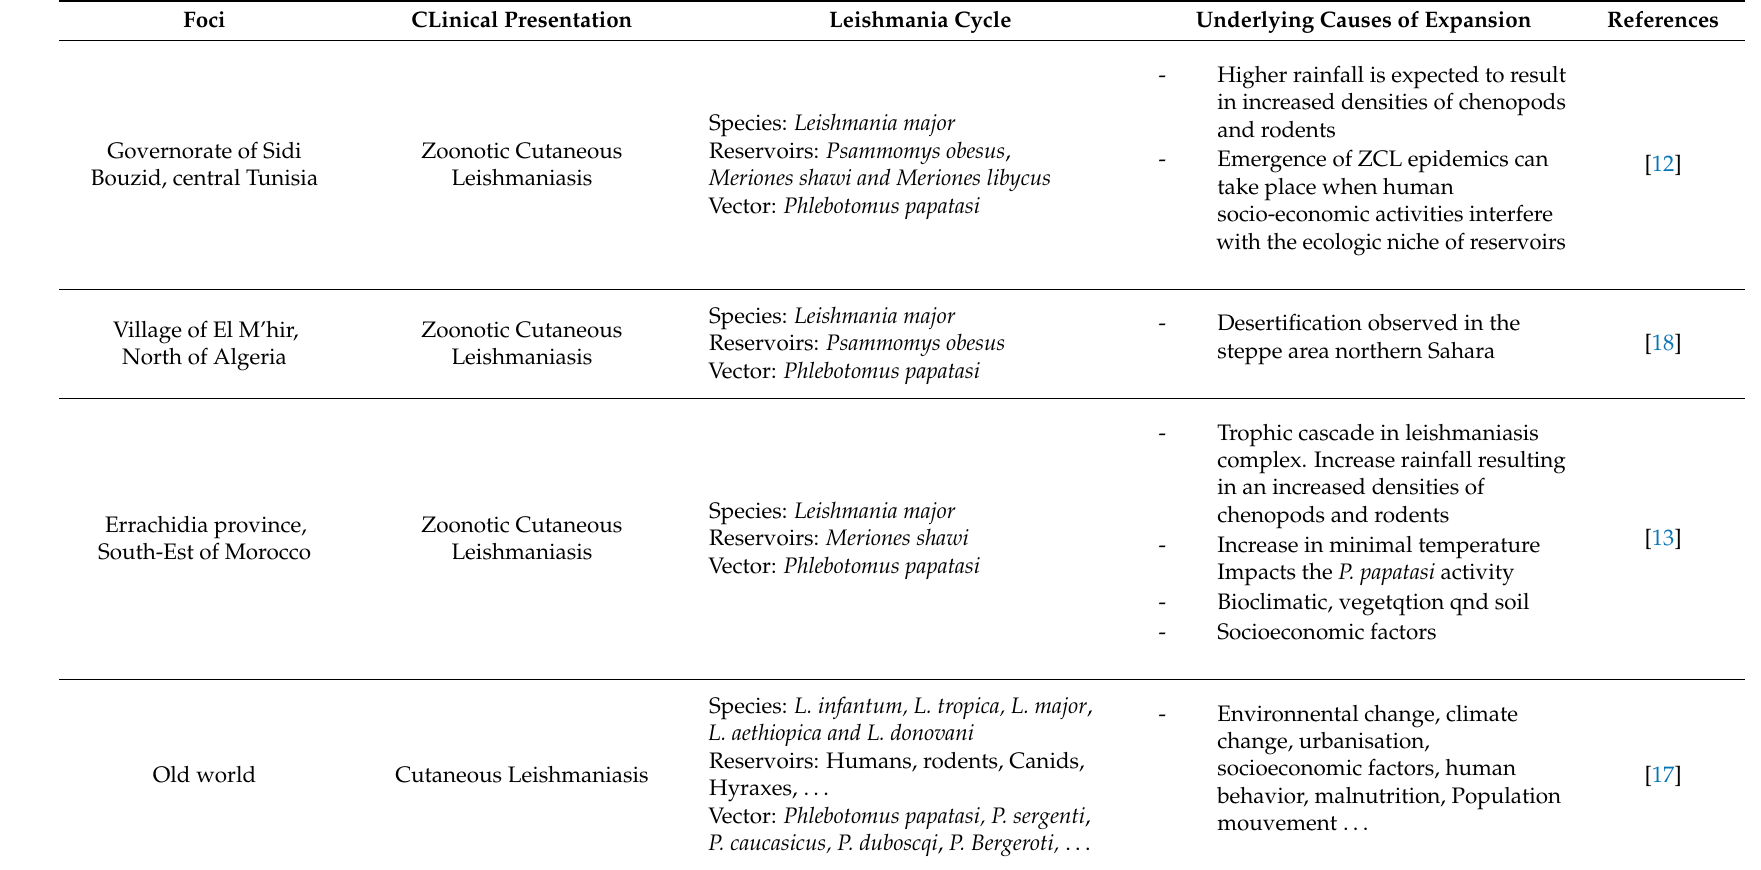
Table 1. Factors that play a role in leishmaniasis, cutaneous leishmaniasis (CL), expansion.